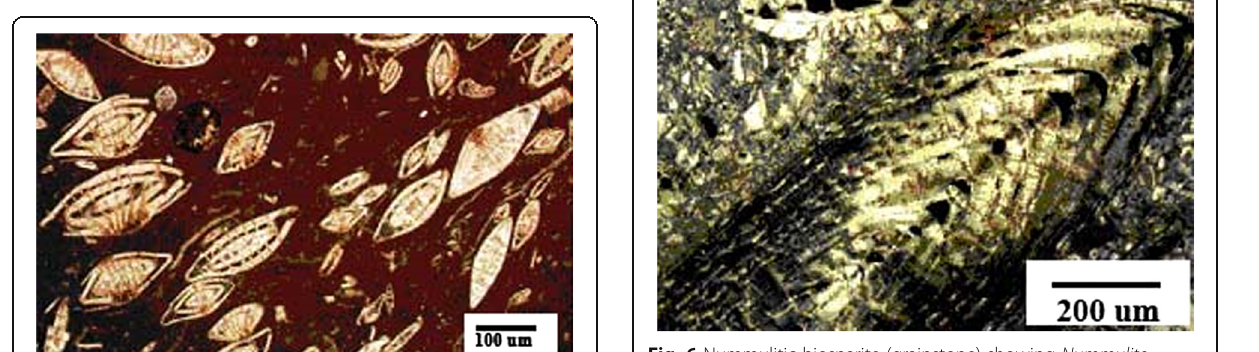
Fig. 6 Nummulitic biosparite (grainstone) showing Nummulite gizehensis are embedded in sparite matrix (grainstone) as well as compaction and dissolution. Note: Nummulite gizehensis filled with sparry calcite and micrite,